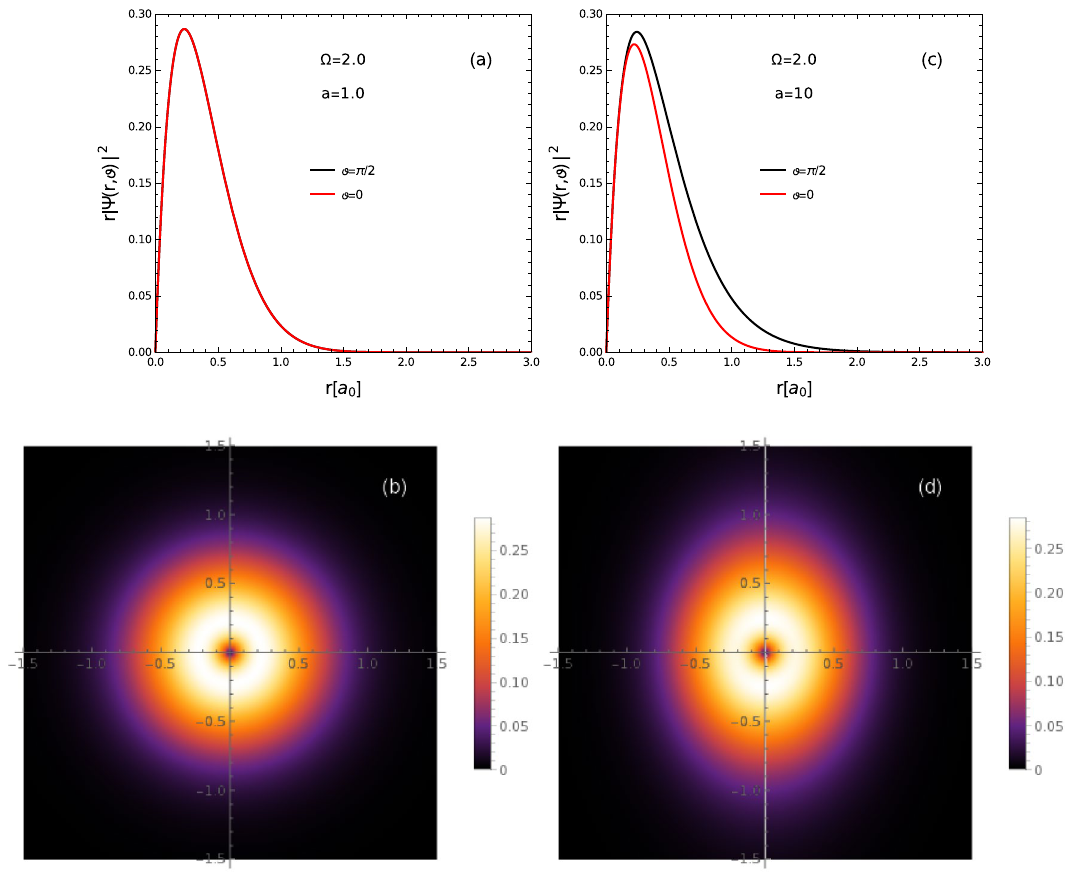
Figure 6. Ground state electron-hole density function (intracule density) of Mott-Wannier exciton for different levels of the deformation of confining potential: ( a ), ( b ) isotropic case ( a = 1 ); ( c ), ( d ) anisotropic case a = 10